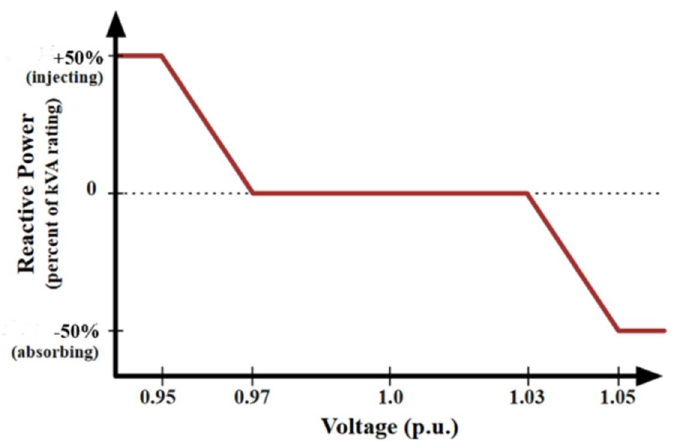
Figure 12. Volt/VAR curve used in the baseline simulation [23].